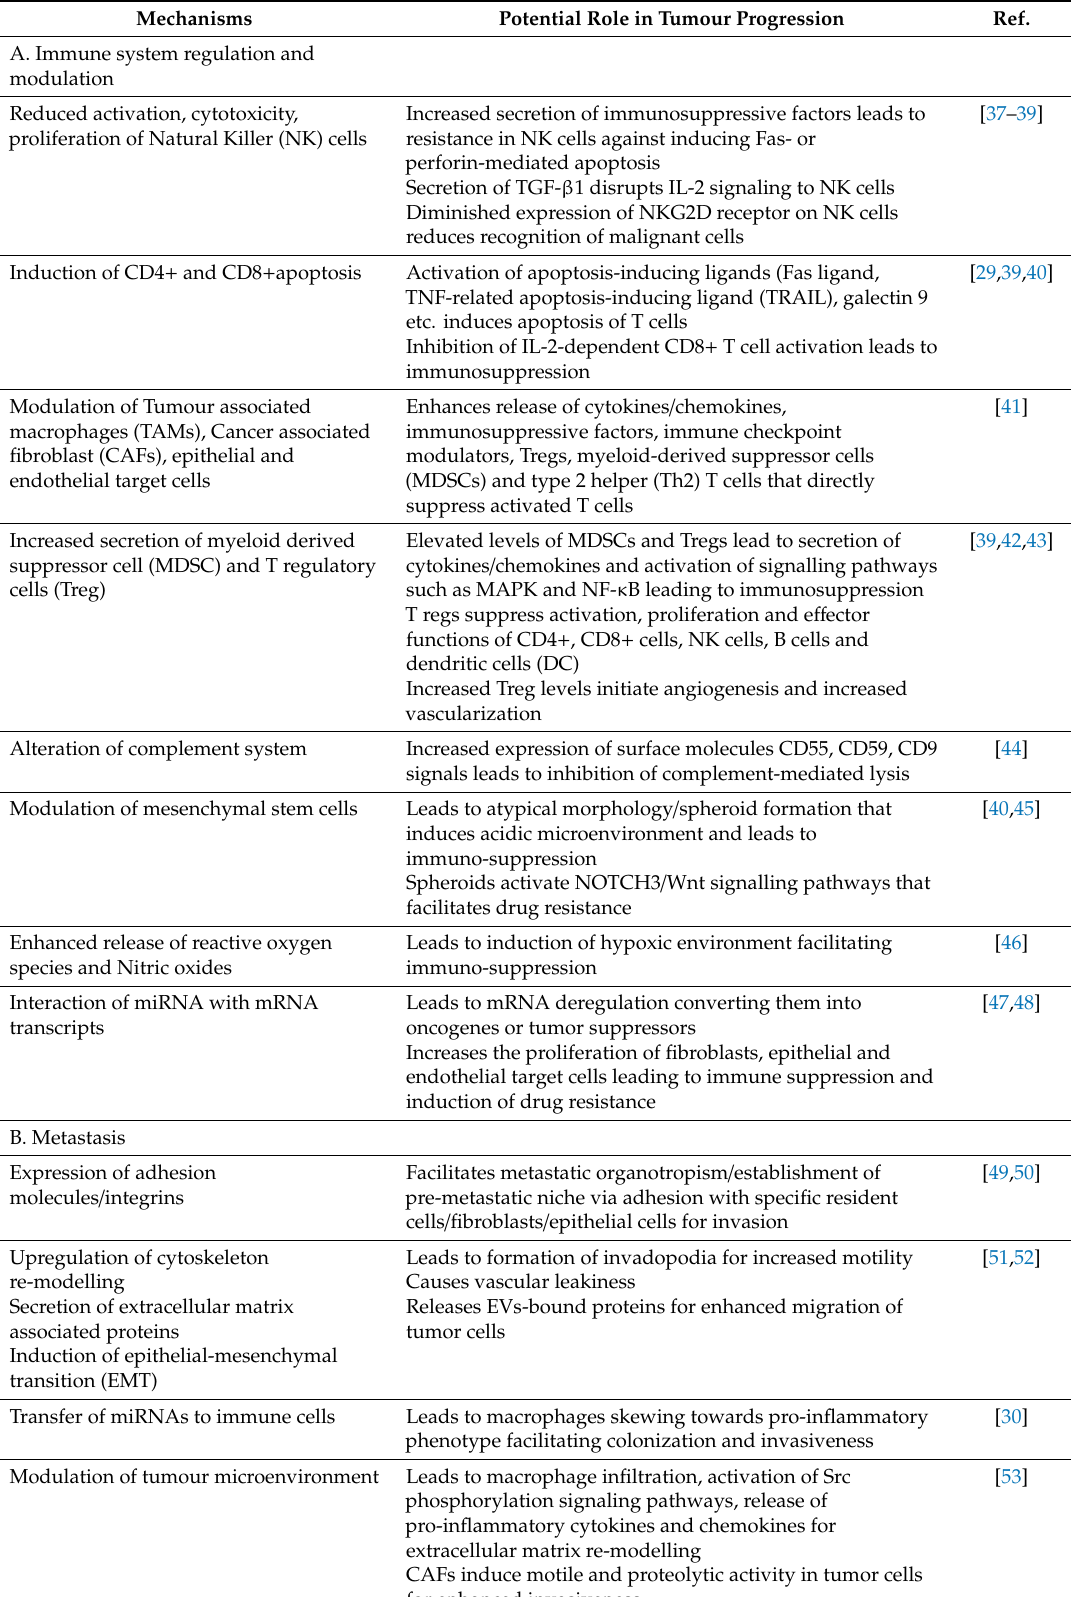
Table 1. Mechanisms of tumor microenvironment modulation by Colorectal cancer-associated extracellular